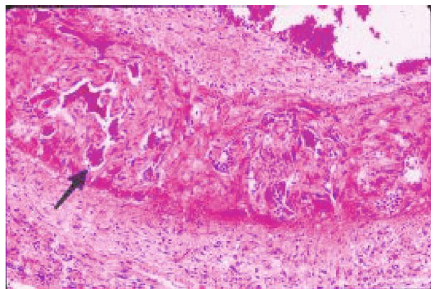
Figure 16: Segmental arterial mediolysis reparative phase. The arrow points to a large irregularly dilated capillary in young granulation tissue repairing a focus of trans medial mediolysis. Hematoxylin & eosin × 200 (adapted with permission from Cardiovascular Pathology 18(6) copyright 2009, Elsevier